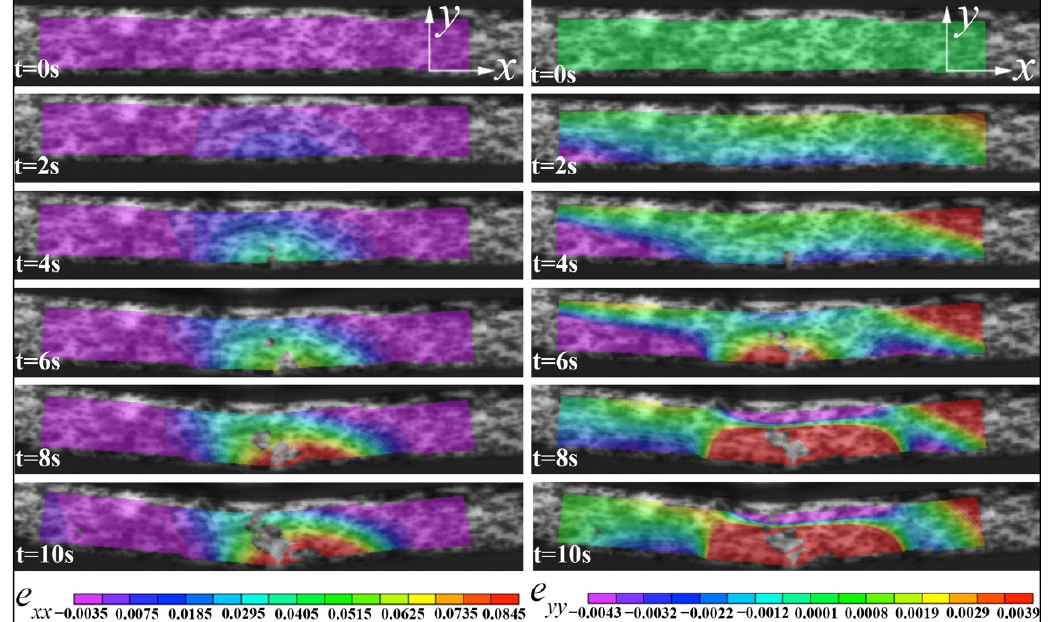
Figure 8. The DIC images of the horizontal strain ( e xx ) and the vertical strain ( e yy ) of ZrO 2 samples under a three-point parallel bending test.